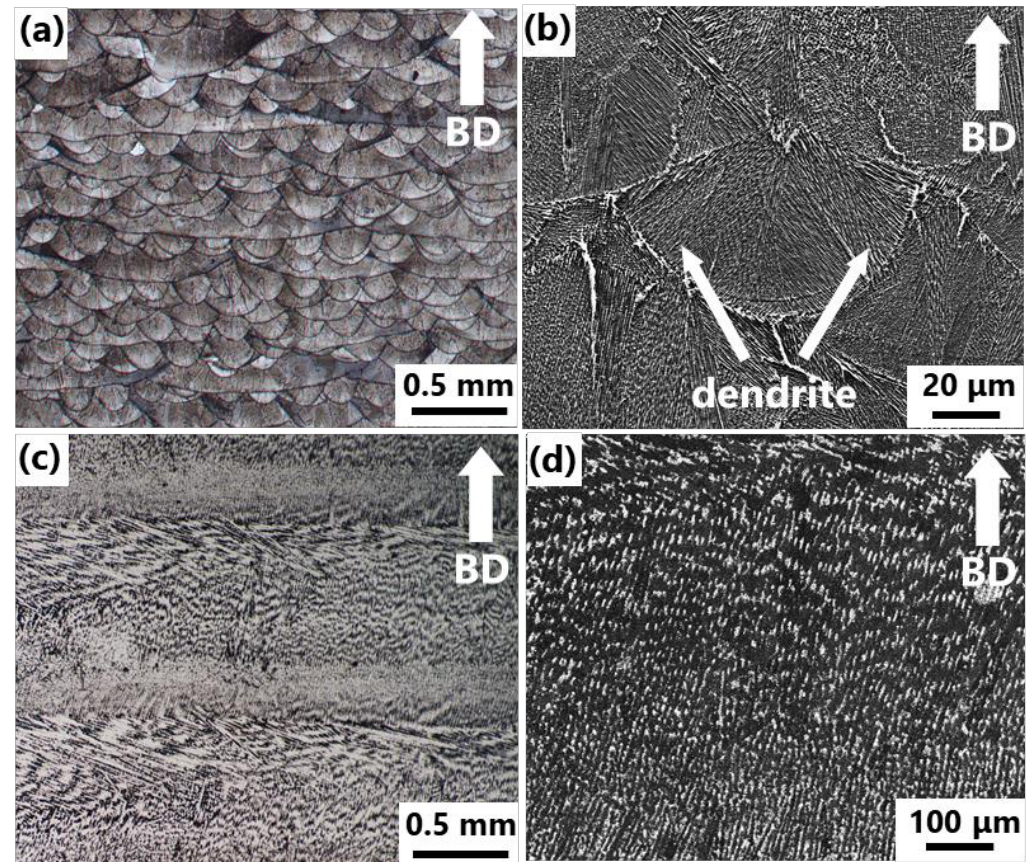
Figure 1. Microstructures of the as-built specimens: ( a , b ) Ar-SLM and ( c,d ) V-SLM.